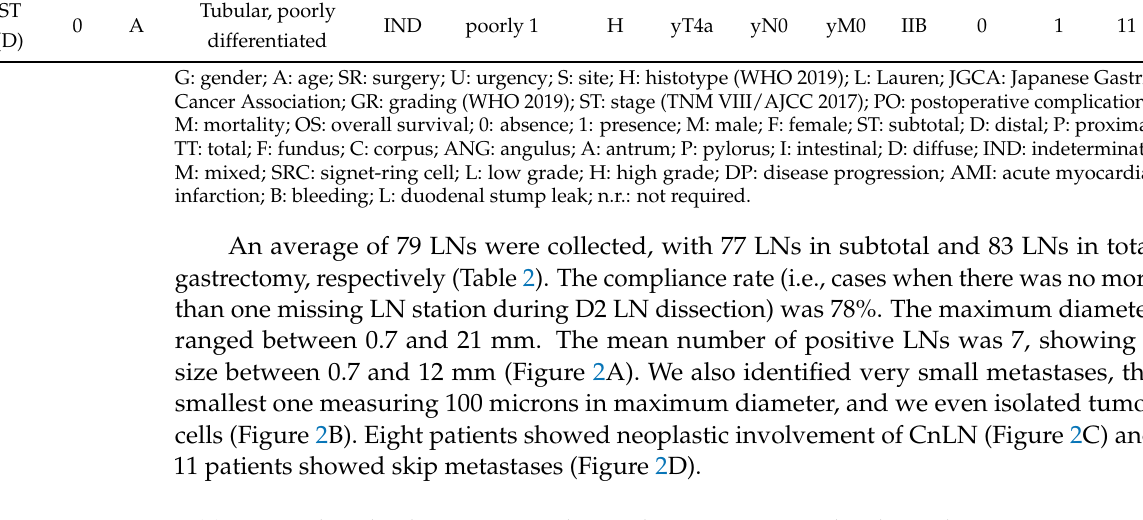
Table 2. Lymph nodes dissection according to the J.G.C.A. protocol in the study